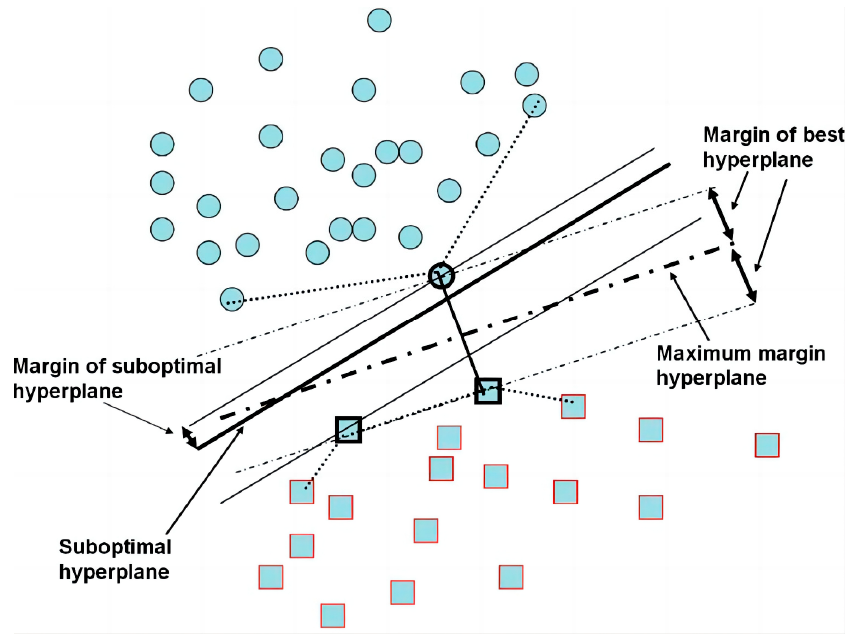
Figure 5. Two hyperplanes for the linear separable binary case. The circle and rectangle represent two different VOCs gases. Reprinted with permission from Ref. [64]. Copyright year 2005, copyright owner Elsevier.